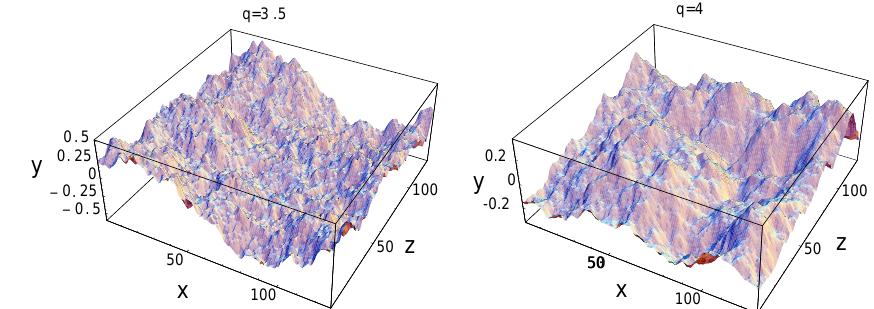
FIG. 6. (Color) Fractal surfaces for (cid:113) (cid:173) (cid:51)(cid:46)(cid:53) and (cid:113) (cid:173) (cid:52) (in arbitrary units). Smaller values of (cid:113) give more “spiky” profiles.